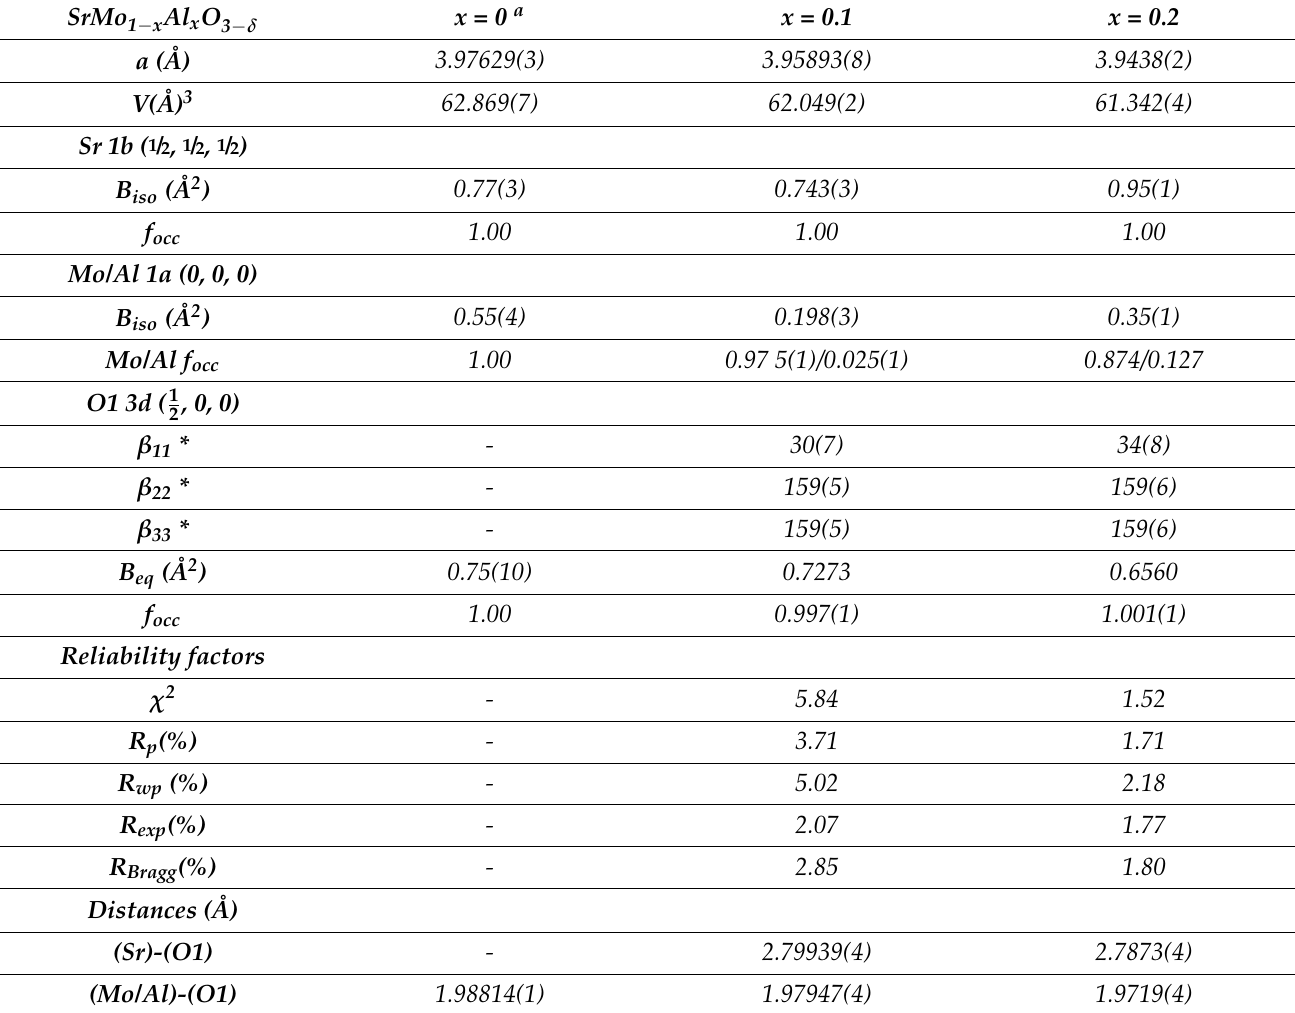
Table 1. Unit-cell and thermal parameters for SrMo 1 − x Al x O 3 − δ (x = 0, 0.1 and 0.2) in cubic Pm-3m (no. 221) space group, from NPD at RT, corresponding to the major perovskite phase. Sr is placed at 1 b (1/2, 1/2, 1/2), (Mo,Al) at 1 a (0, 0, 0), and O at 3 d (1/2, 0, 0)